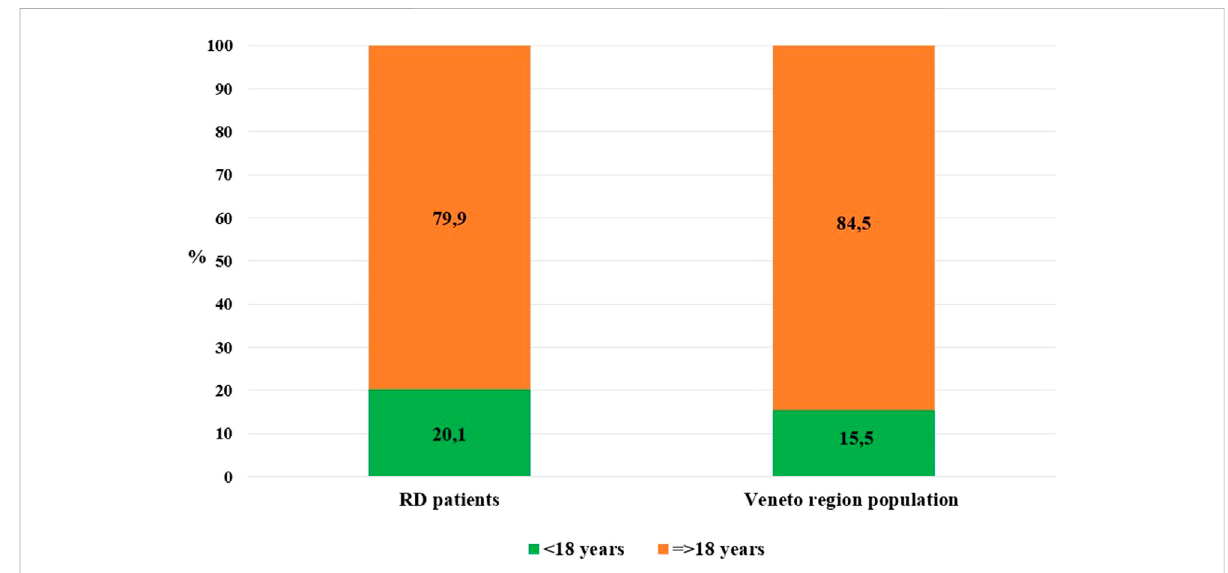
FIGURE 2 Distribution per age class: Veneto region population vs. RD monitored population (year